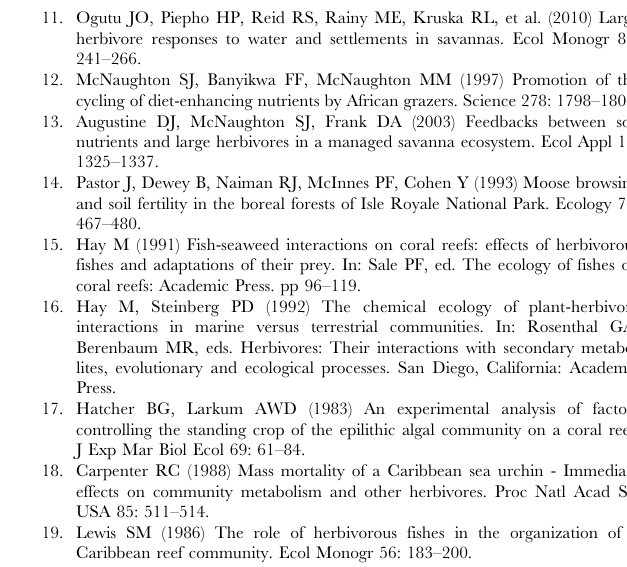
Figure S1 Study area: Mandu and Maud sanctuary zones in Ningaloo Reef, Western Australia. In Mandu, there were three sites within each habitat: lagoon (diamond icons), reef flat (circle icons) and outer reef (square icons). Table S1 PERMANOVA results on removal rates of Sargassum myriocystum lateral branches between sites and habitats.